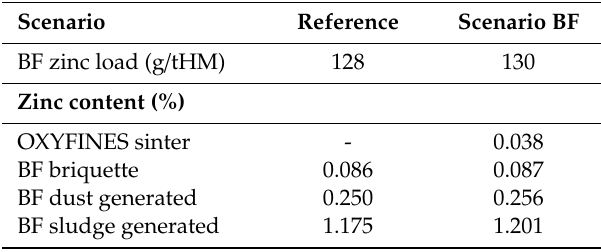
Table 3. Blast furnace (BF) zinc load, zinc content in sinter, briquette, dust, and